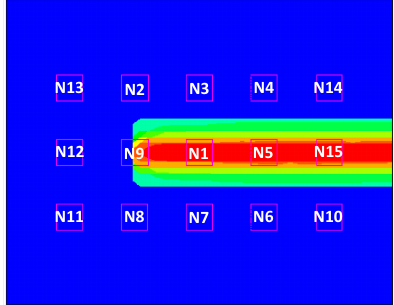
Fig. 2. Top view of the fifteen contacts matrix for the simulation of the alpha particle.